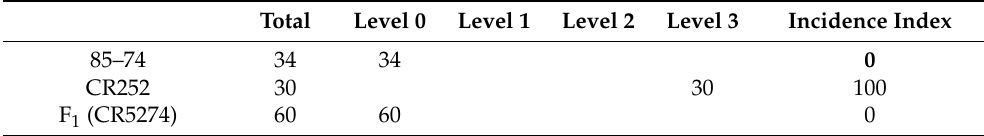
Table 2. Disease-resistance verification results of parental lines and F 1 generation by inoculation of LNXM-1 P. brassicae